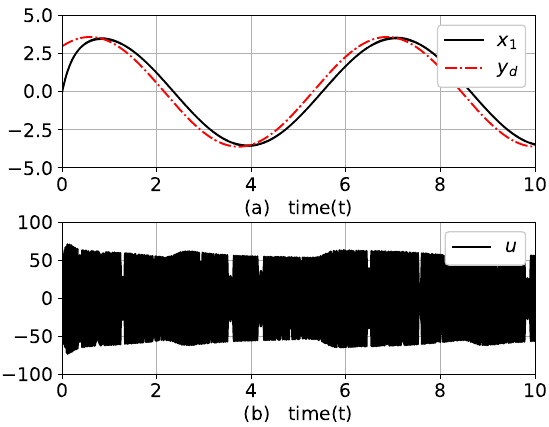
Figure 12. For HOSMD: ( a ) y , y d , and ( b ) u .